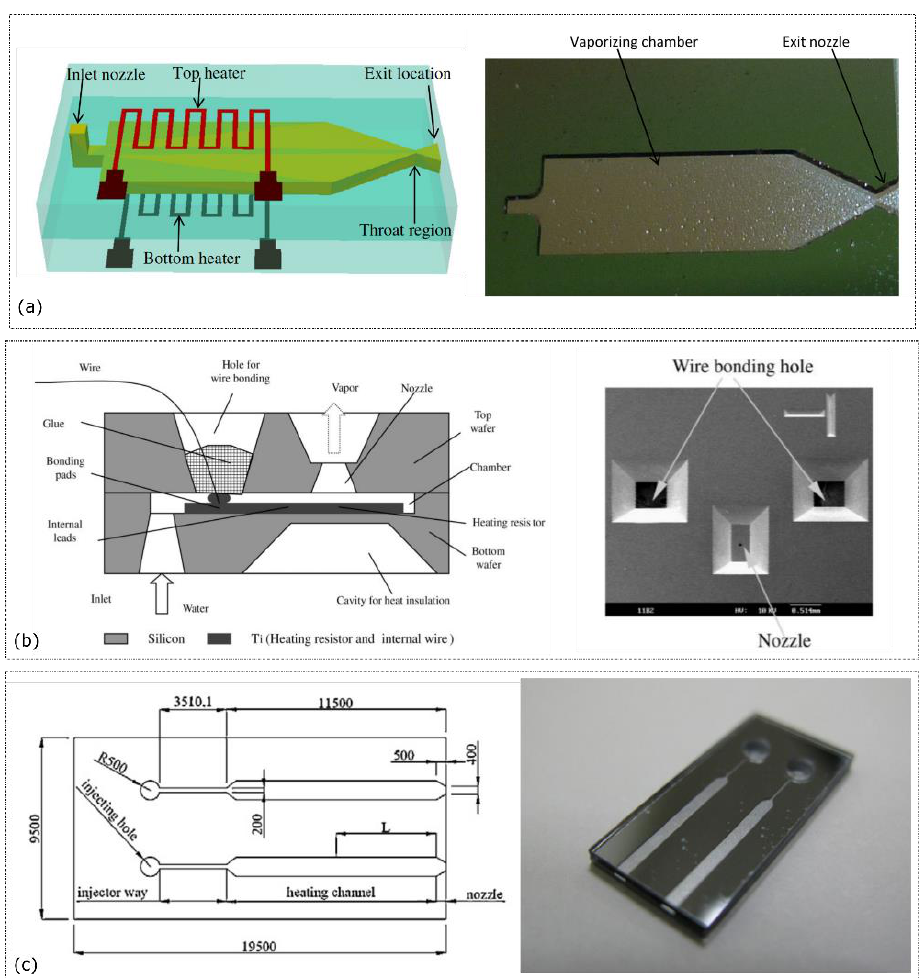
Figure 3. Manufactured VLMs in single channel configuration: ( a ) Kundu et al. [14]; ( b ) Ye et al. [15]; ( c ) Chen et al. [16] (units are in μm).